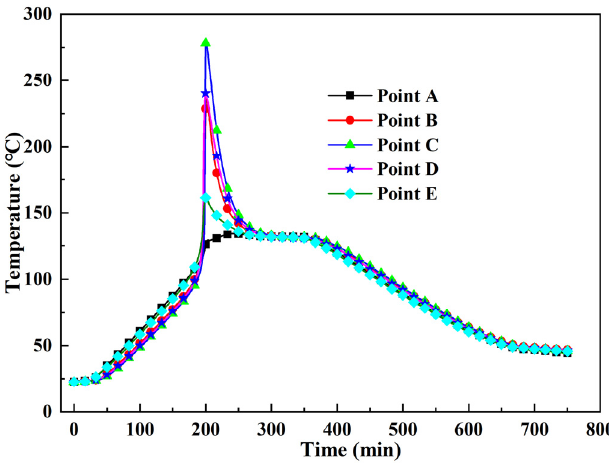
Figure 10. Temperature history of thick AF/EP composites.